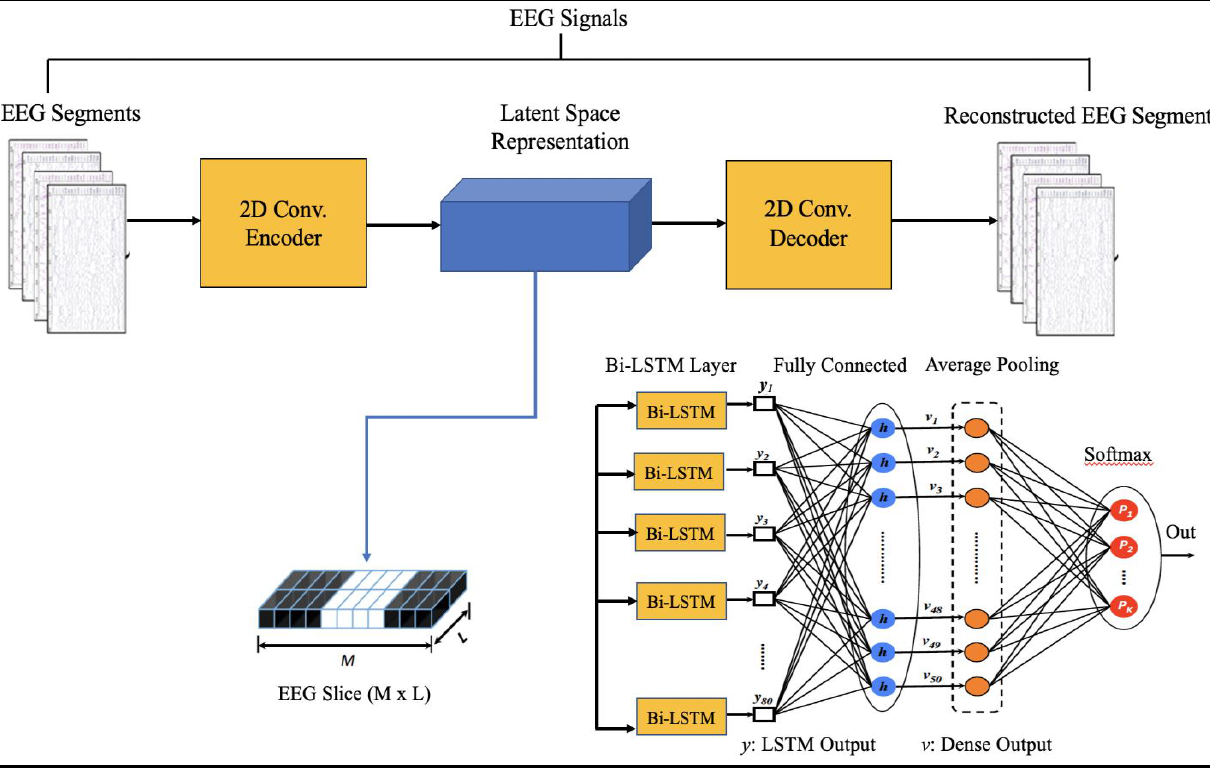
Figure 3. Proposed Architecture.